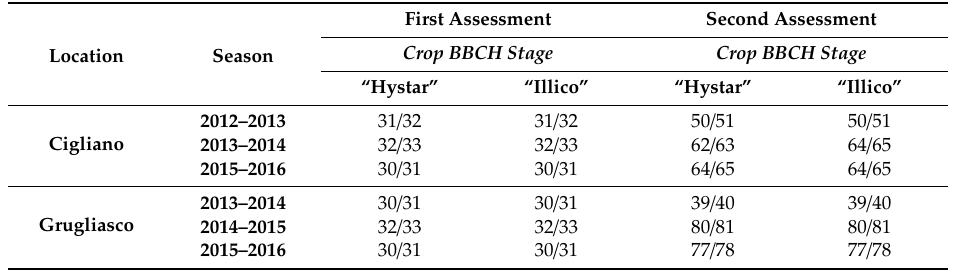
Table 1. Wheat growth stage according to the BBCH scale [25] at the time of weed assessments carried out in the period 2012–2016 at the two